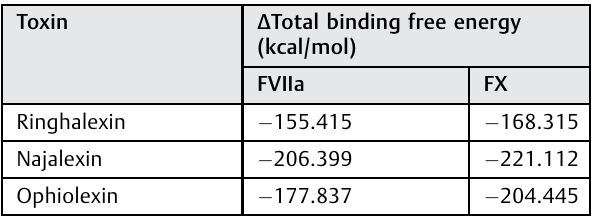
Table 1 Δ totalbindingfreeenergy(kcal/mol) for theringhalexin, najalexin, and ophiolexin docked with FVIIa and FX